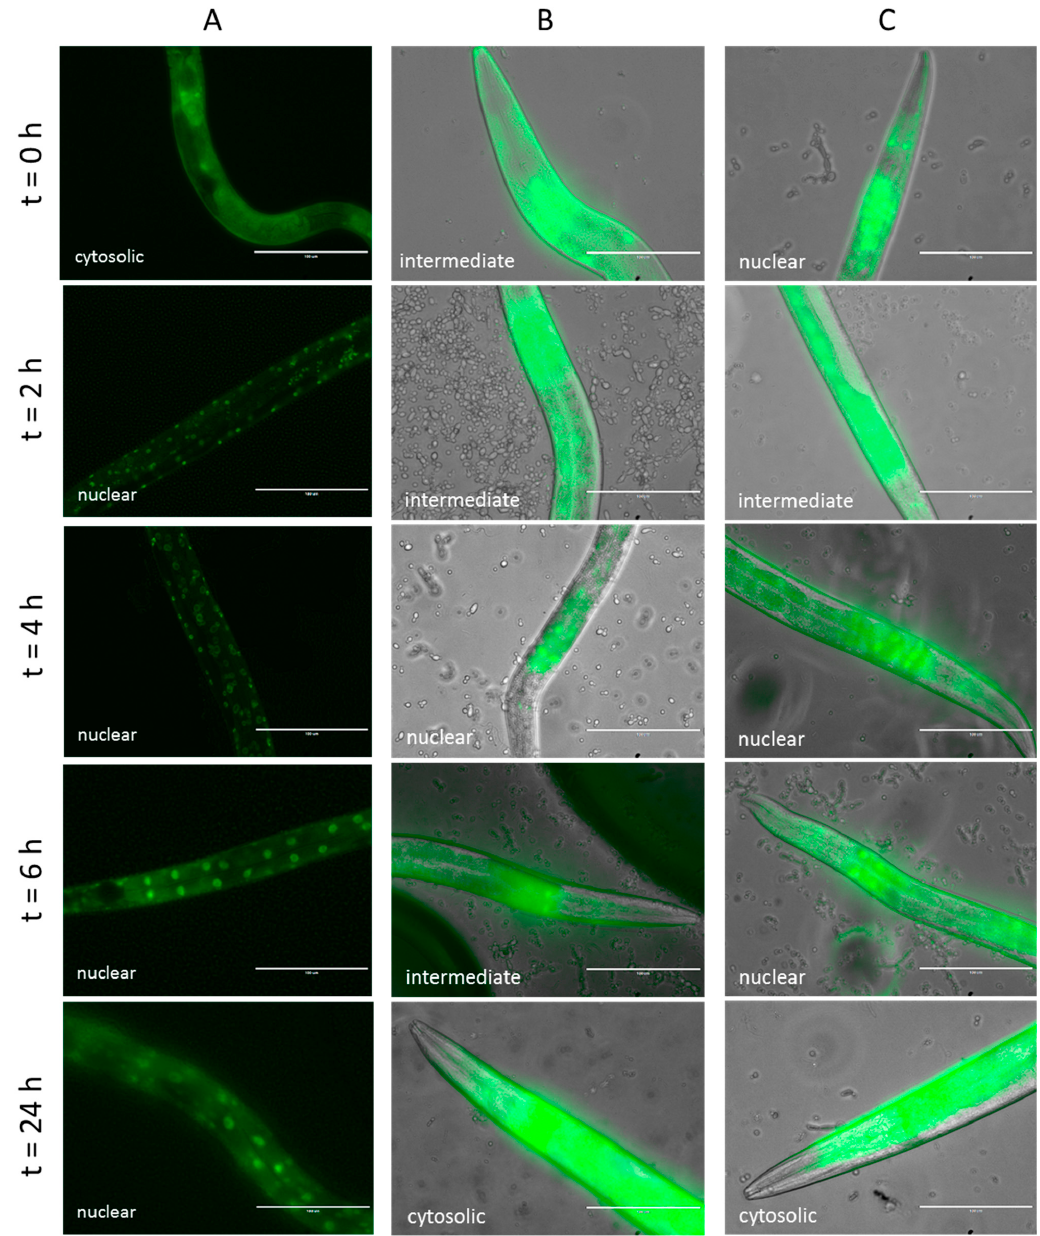
Figure 5. Impact of curative Lcr35 ® treatment on DAF-16 cellular localization in C. elegans transgenic strain TJ-356 expressing DAF-16::GFP. Worms fed on C. albicans only ( A ), on C. albicans + OP50 ( B ), and on C. albicans + Lcr35 ® ( C ). Scale bar, 100 μ m.